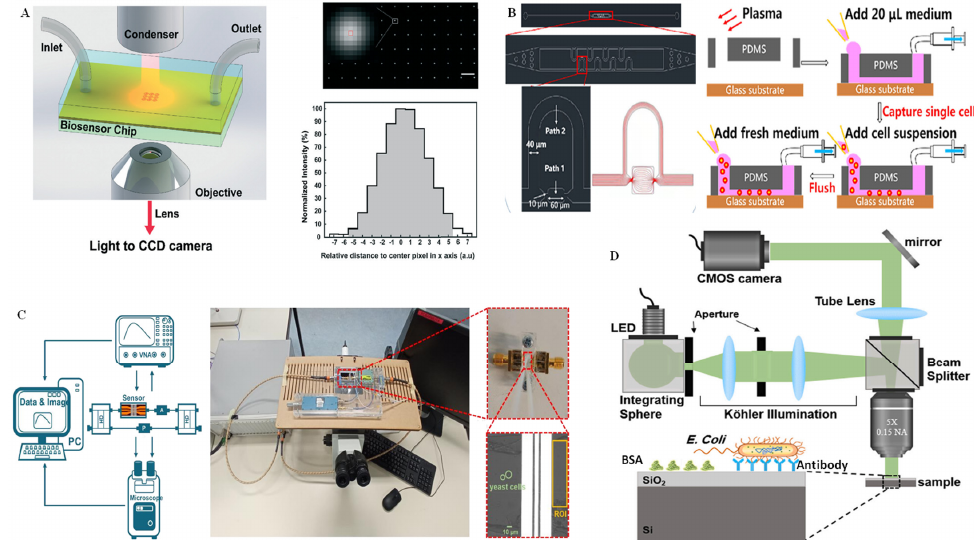
Figure 8. Interferometry technique for single-cell analysis on microchips. ( A ) Schematic illustration of the microfluidic chip integrated with the interferometric imaging system, as well as the inter- ferometer array transmission images from this biosensor for the detection of matrix metallopro- teinase 9. Reprinted with permission from ref. [86], Copyright 2019, Royal Society of Chemistry. ( B ) Schematic diagram of the microfluidic chip channel structure and a partial enlargement of the sin- gle-cell operation process. Reprinted with permission from ref. [87], Copyright 2021, International Society for Advancement of Cytometry. ( C ) Schematic overview of the microfluidic chip integrated with a microwave interferometric cytometry system and a physical photo of the chip instrument. Reprinted with permission from ref. [89], Copyright 2022, MDPI. ( D ) Schematic diagram of the